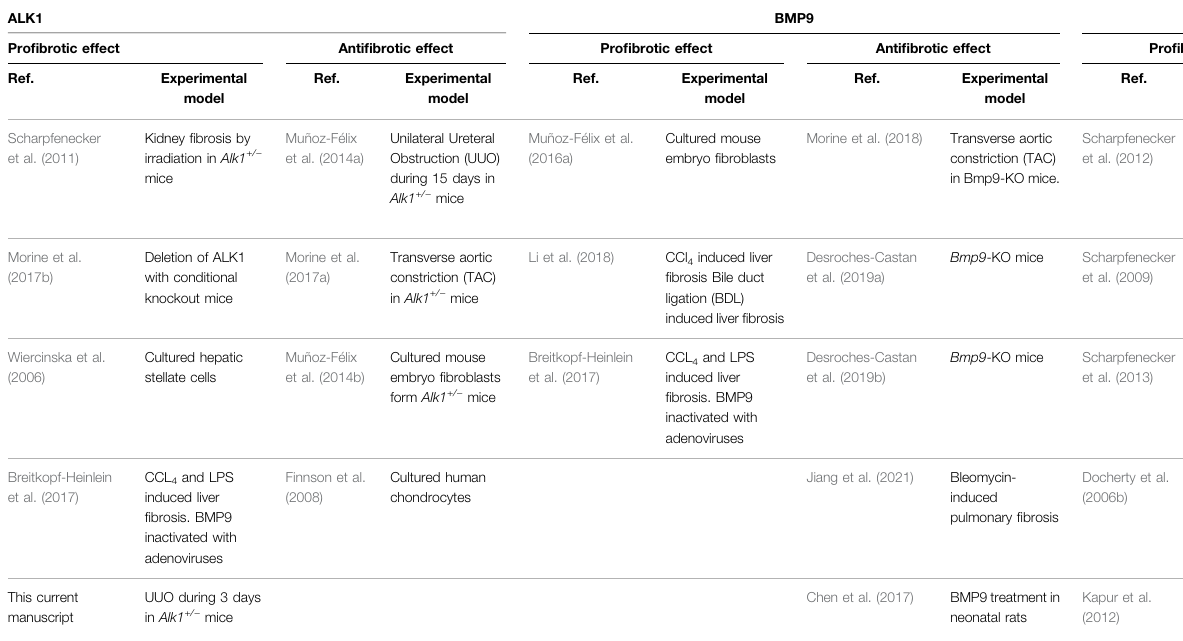
TABLE 1 | ALK1, BMP9 and Endoglin effects in tissue fi